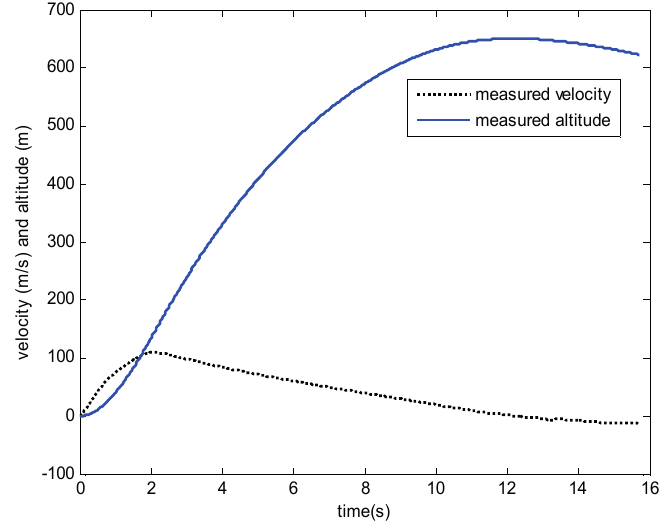
Figure 20. Velocity and altitude from Smokey